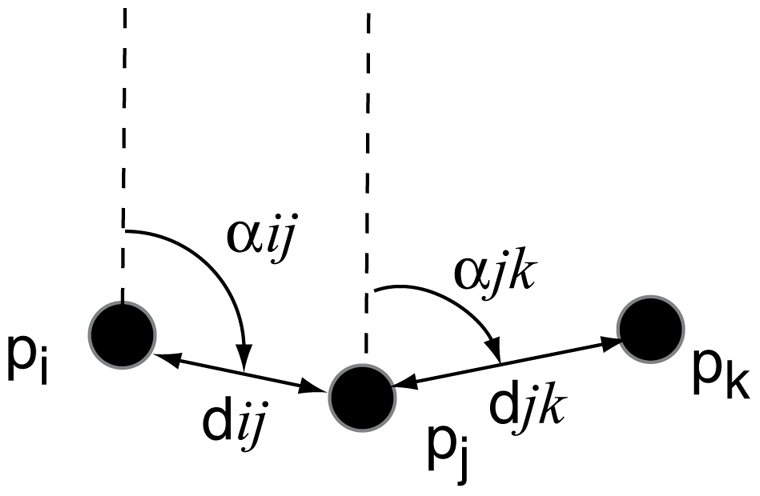
Illustration of the measurement method.We define  and dij as the angle and distance between pedestrians i and j, where i and j belong to the same group and j is i's closest neighbour on the right-hand side.